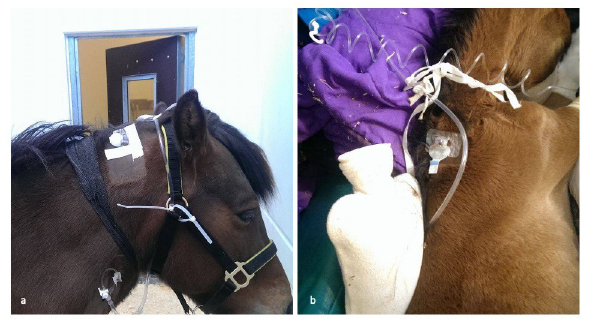
Fig 1. Attachment of the CGM system to an adult horse (a) and to a foal (b).